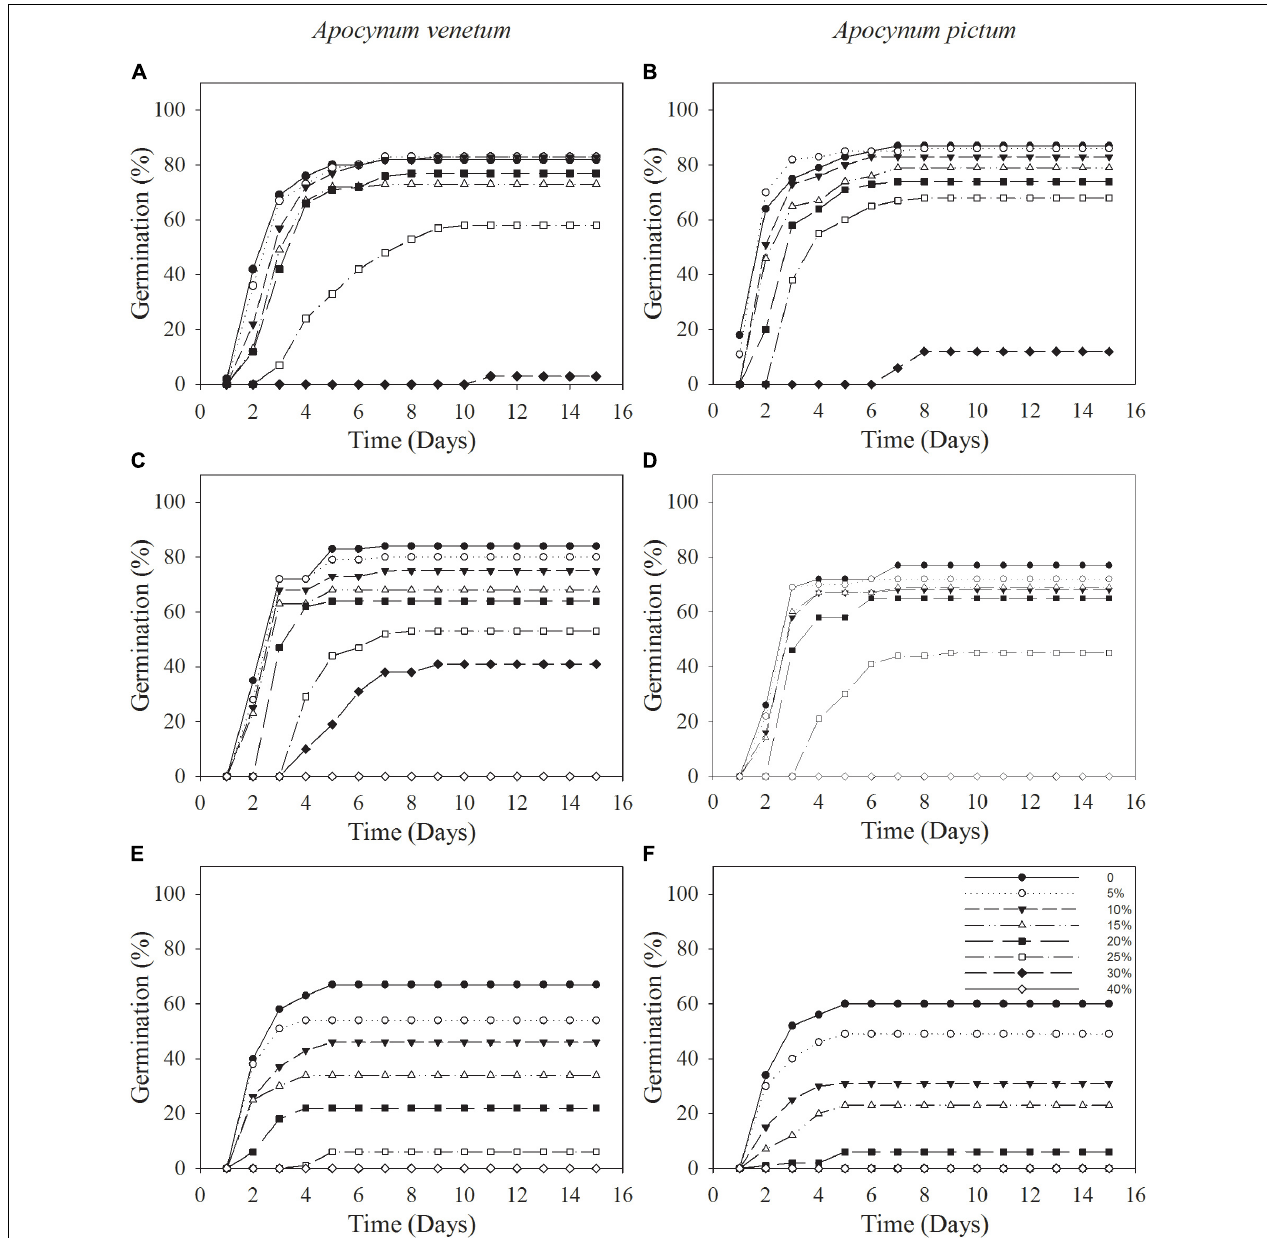
FIGURE 3 | Cumulative germination percentages of Apocynum venetum and Apocynum pictum seeds stored for 0 year (A,B) , 1 year (C,D) , and 2 years (E,F) under different PEG